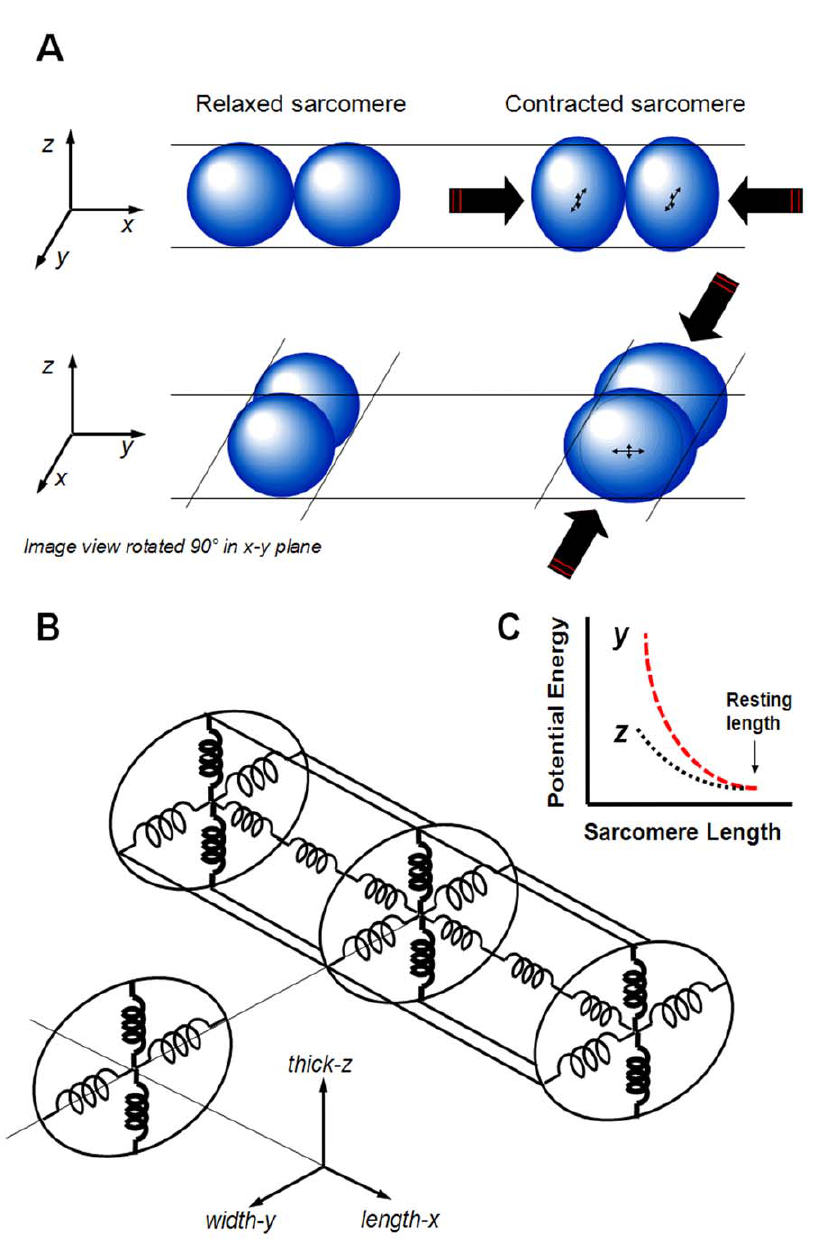
Figure 7. Scheme of mitochondrial 3D-deformation and proposed cytoskeleton mechanical analog. (A) Asymmetric radial expansion of mitochondria when compressed longitudinally by the sarcomeres during active contraction. While the mitochondria compress in the length-axis ( x ) they expand in the width-axis ( y ); however, the expansion in the thick-axis ( z ) is quite distinct from the width expansion. (B) An ‘‘equivalent spring’’ model of the cardiomyocyte cytoskeleton relevant to sarcomere lengths achieved during contraction, and capable of storing contractile energy during active cell shortening, then releasing this potential energy during relaxation as external work performed to relengthen the cell. The cytoskeleton is apparently stiffer in the cardiomyocyte thick-axis (shown in bold ) compared to the width-axis. (C) Based on a simple analog of Hookean springs, during cardiomyocyte contraction the elastic components of the cytoskeleton store more potential energy in the cell’s width -axis compared to the thick -axis (see text for